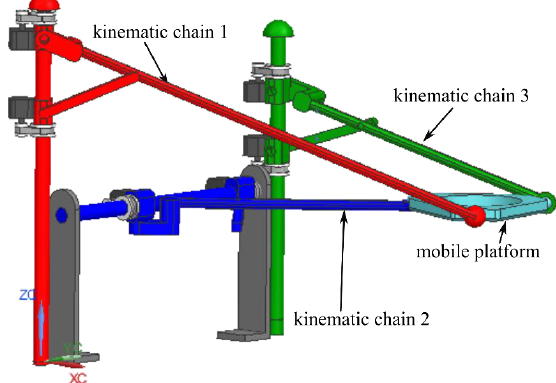
Figure 20. Output singularity configuration for the angle values { ψ = 0, θ = 0, φ = 0}.